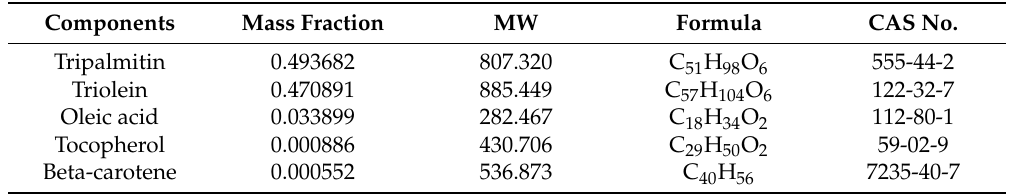
Table 2. Composition of refined palm oil and its properties.